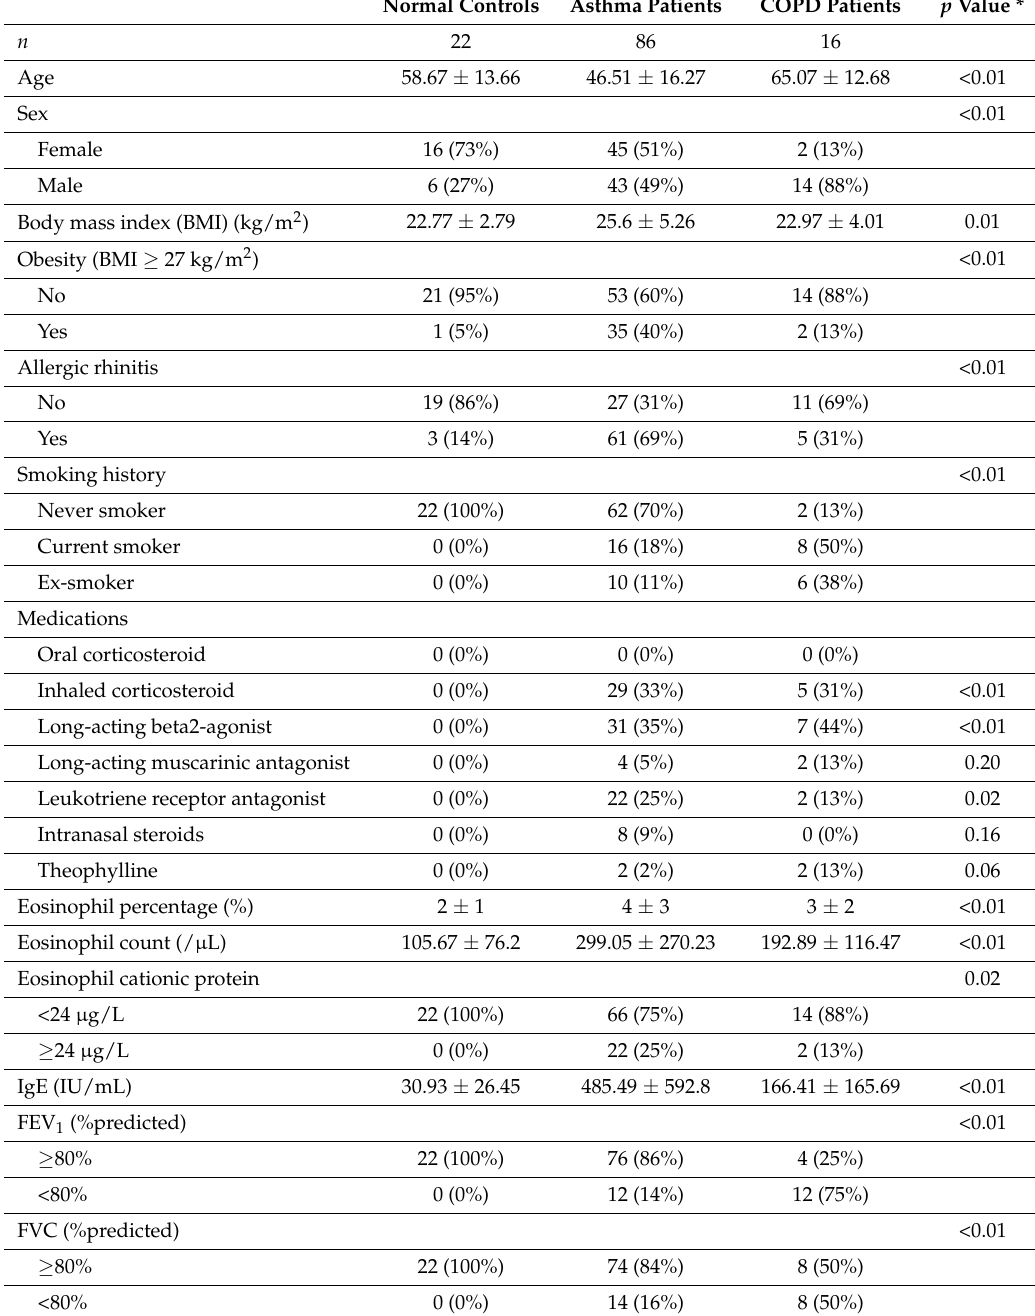
Table 2. Baseline characteristics of the study